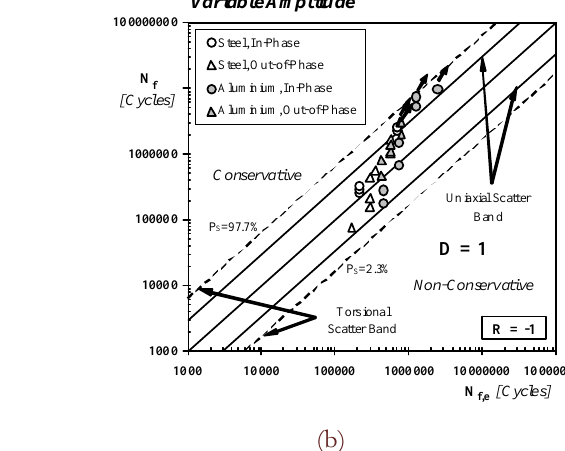
Figura 7: (a) Stime per sollecitazioni ad ampiezza variabile su giunti in lega di alluminio, in cui il metodo CWM è calibrato sui dati sperimentali di Tab. 1ed applicato in tensioni nominali. (b) Stime per sollecitazioni ad ampiezza variabile, in termini di tensioni strutturali